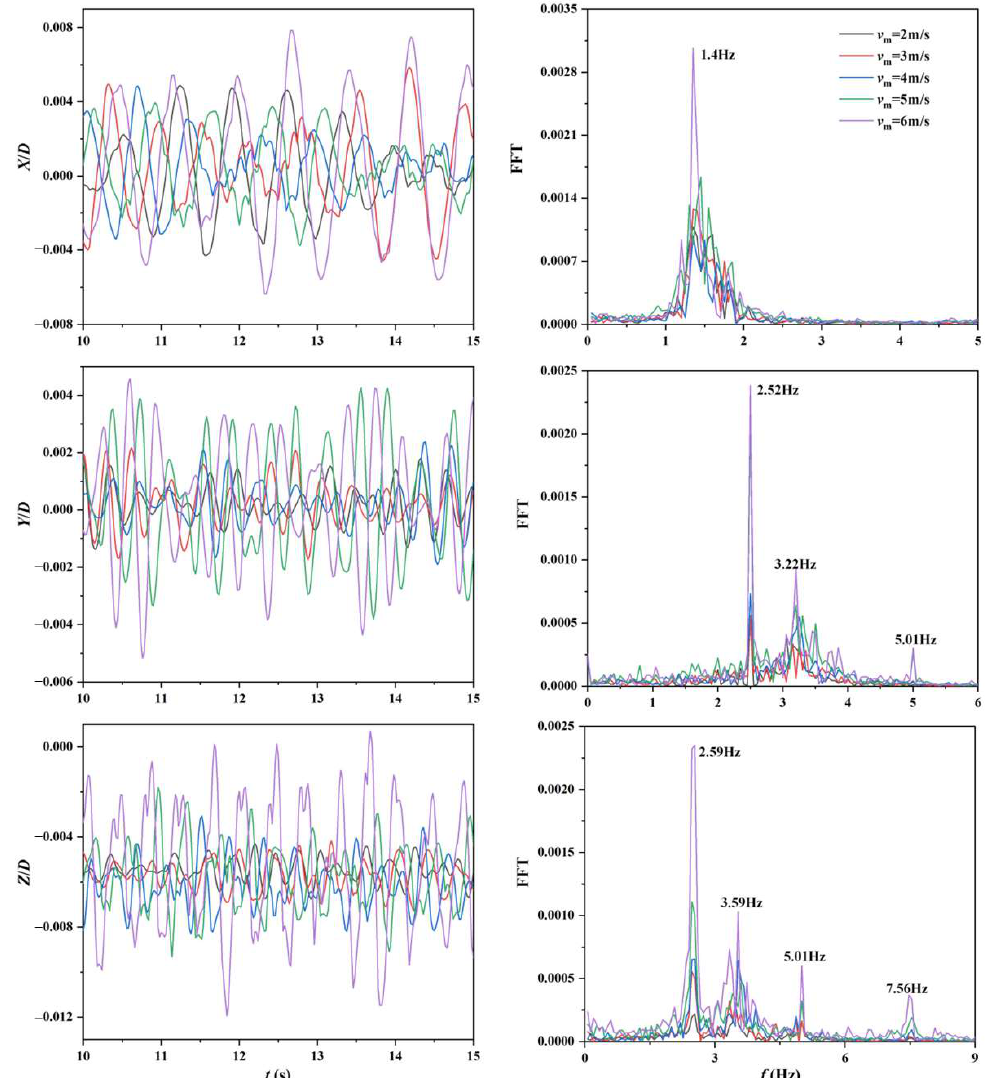
Figure 19. Comparison of the vibration response of the midspan of the bottom horizontal tube (Probe C) at different mixture velocities, where v m is the mixture velocity, and X / D , Y / D and Z / D are the normalized displacements in the three directions.